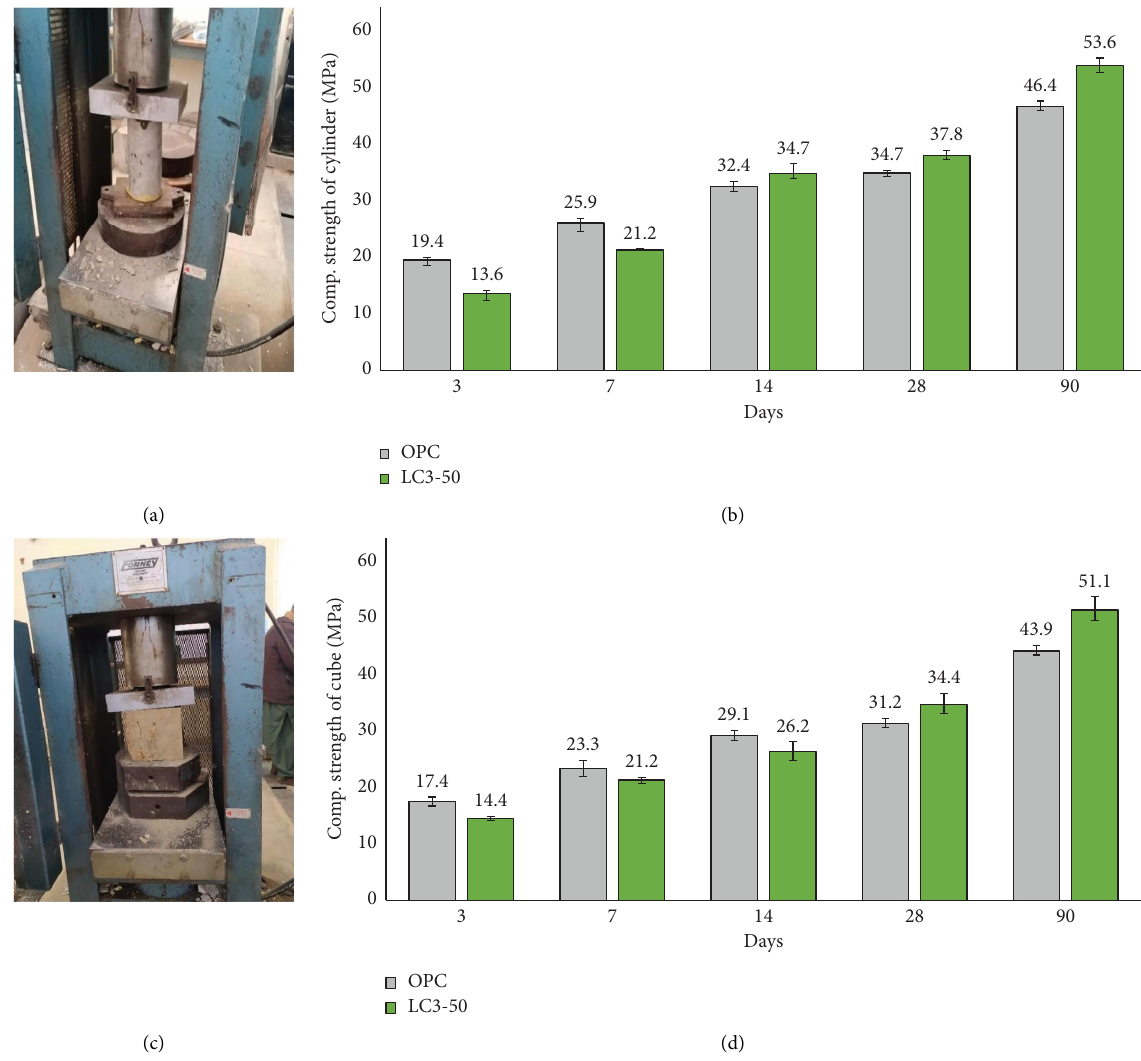
Figure 2: Results of compressive strength of OPC and LC 3 -50 cement-based concrete samples on 3, 7, 14, 28, and 90 days of curing. (a) Setup for the determination of the compression test of concrete cylinders. (b) Compressive strength of cylinders cast from LC 3 -50 and OPC-based concretes. (c) Setup for the determination of the compression test of concrete cube. (d) Compressive strength results of cubes cast from LC 3 - 50 and OPC-based